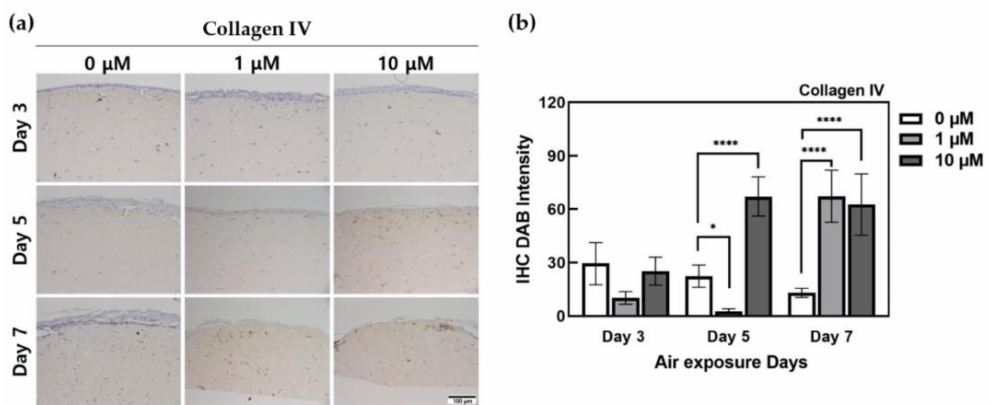
Figure 7. Immunohistochemistry-stained images for collagen IV of HSEs treated α -lipoic acid concentration of 0, 1, and 10 µ M. ( a ) This is the result of collagen IV expressed by IHC staining in HSEs. The x-axis is listed by ALA-treated concentration, and the y-axis is listed by ALA-treated period. The scale bar is 100 µ m. ( b ) This is a graph of quantification of DAB intensity for immunohistochemistry staining of collagen IV protein using the ImageJ program. ( n = 4; *, p < 0.05; ****, p < 0.0001 vs. 0 µ M for each